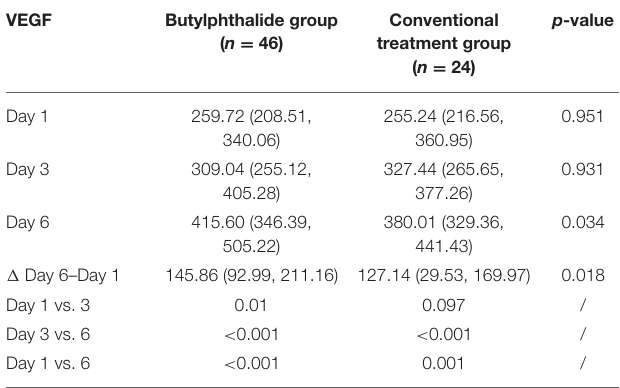
TABLE 3 | Changes in vascular endothelial growth factor (VEGF) after admission according to the treatment groups.